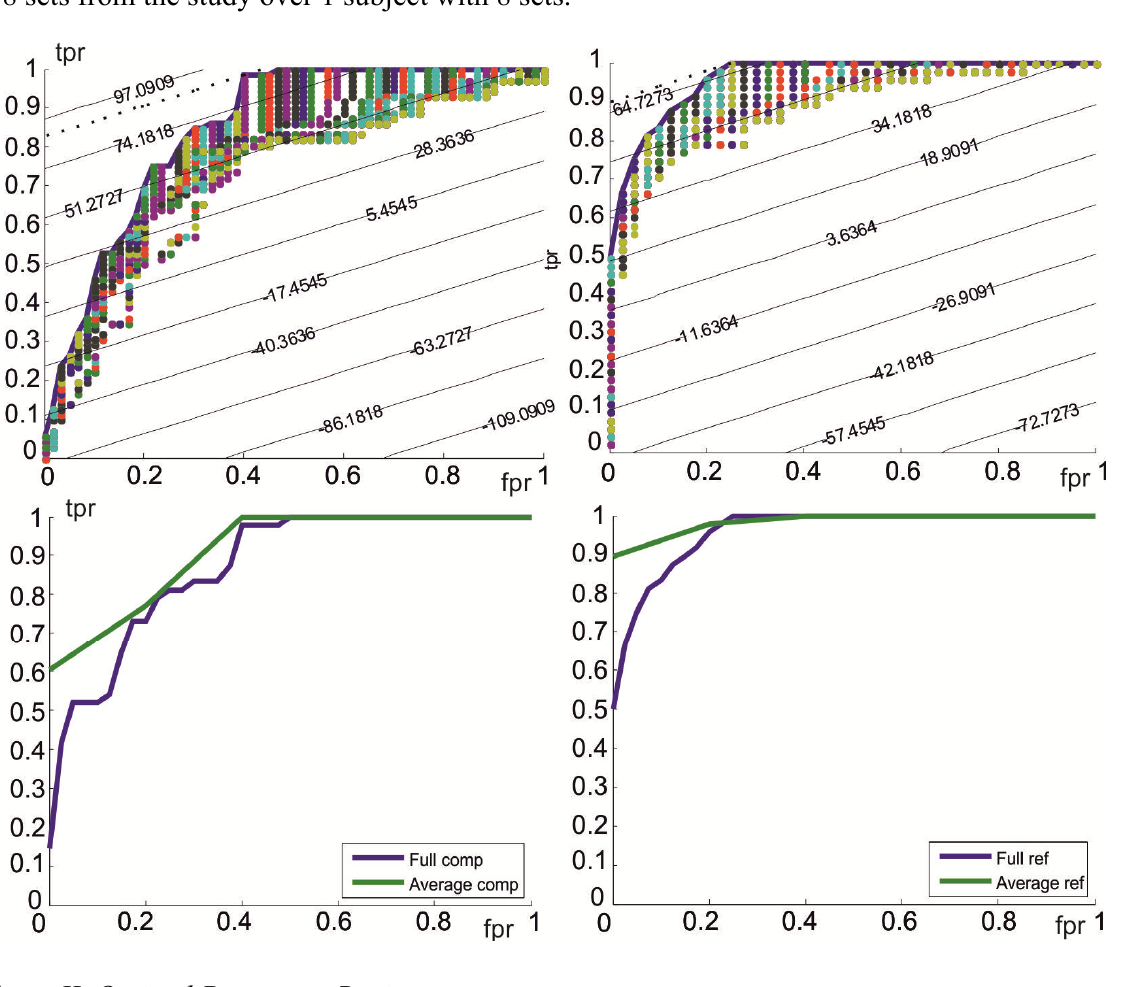
) against the full avg